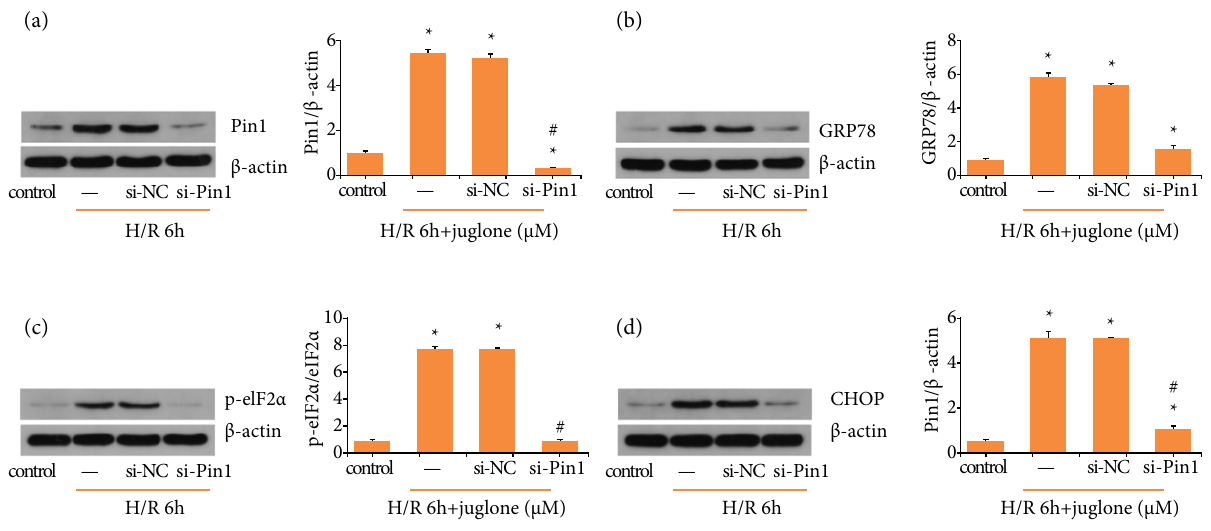
Figure 5 - Pin1 silence alleviated endoplasmic reticulum stress induced by H/R. (a) HK-2 cells were transfected with negative control or si-RNA for Pin1 and subjected to H/R after transfection 24 h. Western blot was performed for Pin1 expression and quantification relative to control group. (b–d) The effect of si-Pin1 on the expression of GRP78, p-eIF2 α , and CHOP after H/R and quantification relative to control group. Values were expressed as the mean ± SEM (n = 8). *P < 0.05, relative to control group; #P < 0.05, relative to the si-NC